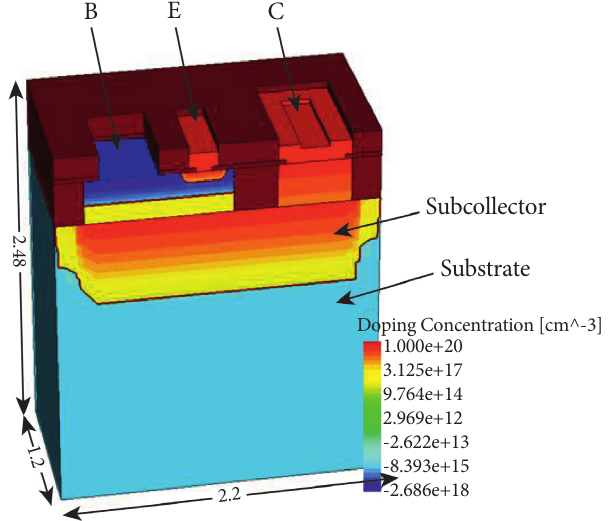
Figure 1: 3D model of the NPN transistor.